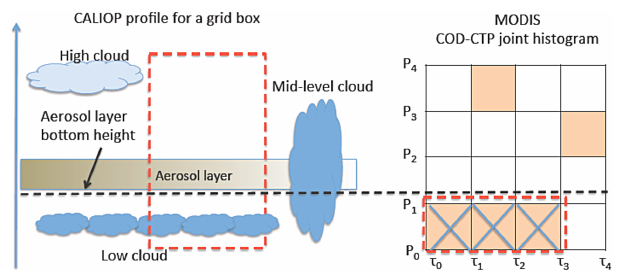
Figure 1. A schematic example to illustrate how CALIOP aerosol layer height information is used in our method to determine the pop- ulation of liquid-phase clouds below the aerosol layer in the MODIS COD–CTP joint